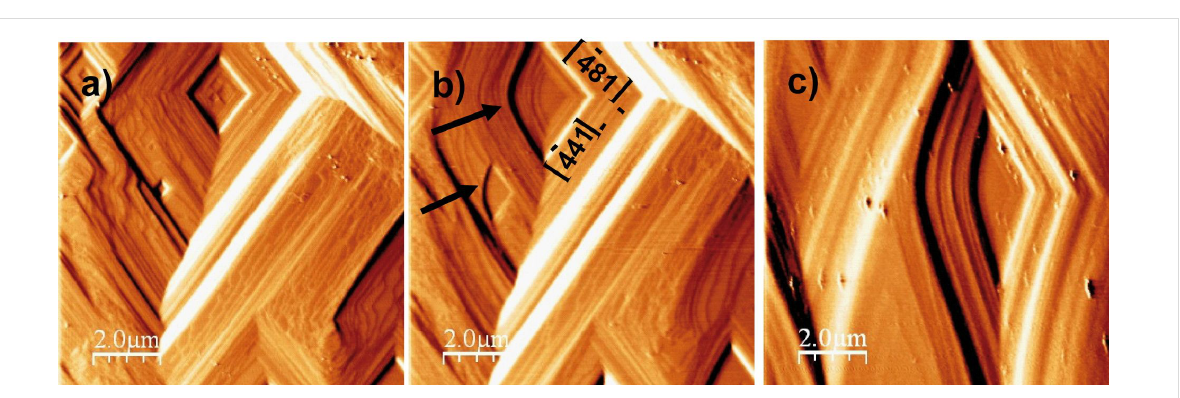
Figure 3: Sequential AFM deflection images of the reacted calcite cleavage surface in contact with Na 2 SO 4 solution: a) characteristic morphology of rhombohedral etch pits (after acid injection, pH 4.08) and b) rounding of the obtuse–obtuse corner of the rhombohedral etch pits (shown by arrows) after 12 min, and c) rhombohedral etch pit with elongated shape after 43 min with a short/long diagonal ratio of 0.35 ±